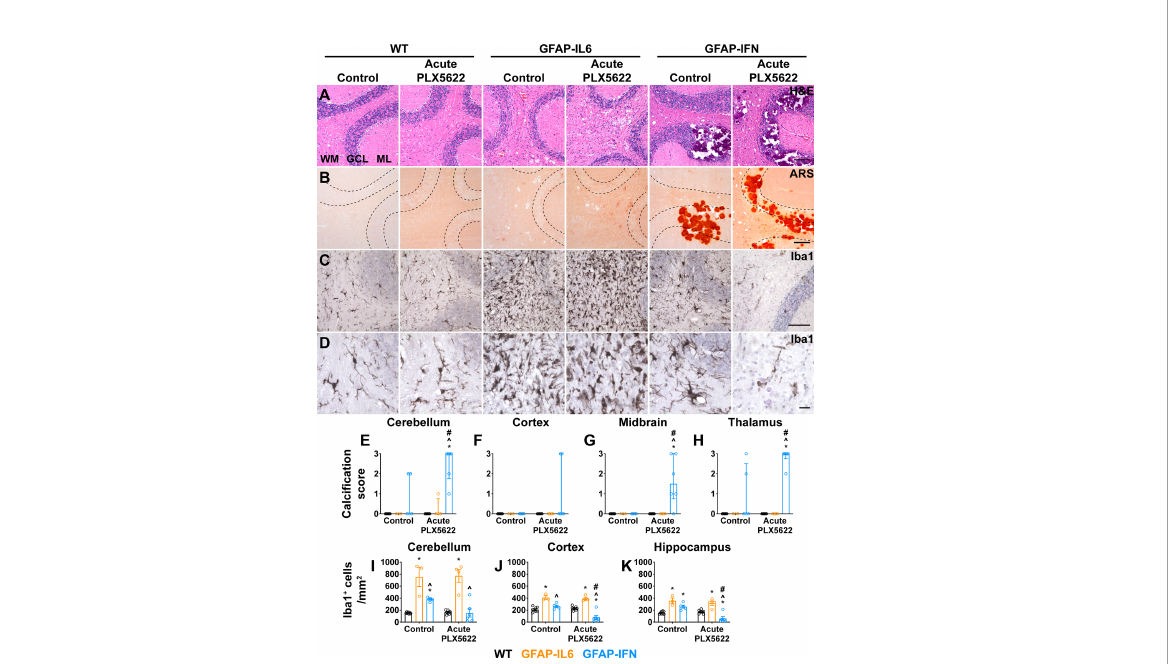
FIGURE 9 Ten weeks following PLX5622 withdrawal, GFAP-IFN mice but not GFAP-IL6 mice recapitulate the molecular phenotype observed in chronic PLX5622- treated mice. (A – D) Representative images of the cerebellum of mice treated with control or PLX5622 diet for 2 weeks, followed by 10 weeks on control diet. (A) H&E, (B) ARS and (C, D) Iba1. WM: white matter, GCL: granule cell layer and ML: molecular layer. Scale bars for (A – C) , 100 m m. Scale bars for (D) , 20 m m. (E – H) Calci fi cation scores in the (E) cerebellum, (F) cortex, (G) midbrain and (H) thalamus. (I – K) Quanti fi cation of the total number of Iba1 + microglia per mm 2 in the (I) cerebellum, (J) cortex and (K) hippocampus. n=3-8 mice/group. For (E – H) , graphs show individual values per mouse and median + interquartile range. For (I – K) , graphs show individual values per mouse and mean ± SEM. For (E – H) , signi fi cance was